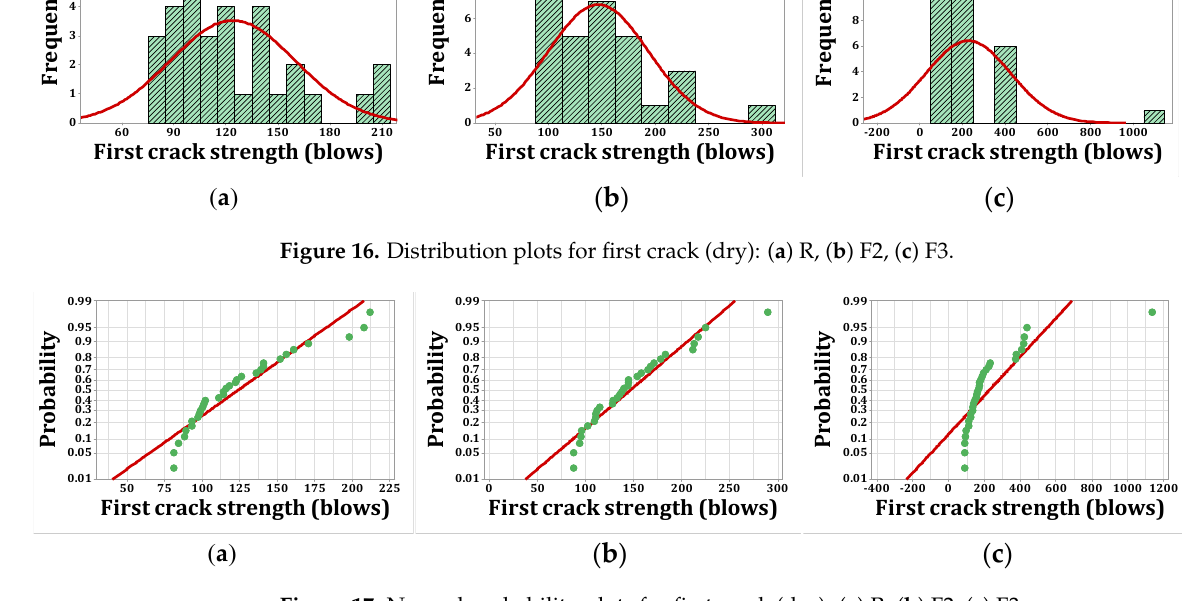
) b ( ) a ( Figure 18. Distribution plots for first crack (dry): ( a ) F5, ( b ) F2F3. ) b ( ) a ( Figure 19. Normal probability plots for first crack (dry): ( a ) F5, ( b ) F2F3. Figure 12a shows the frequency histograms, along with the normal plot, for reference concrete processed in a wet environment, which means that the resistance of the first crack of the reference concrete rarely follows a normal distribution. In addition, Figure 13a shows the normal probability plot of this mix. There is a low curvature plot in the lower half of the straight line that indicates a rarely normal distribution. On the other hand, the normal distribution of results was examined by the Kolmogorov–Smirnov test with a sig- nificance level of 0.05 (reported in Table 8). The p -value obtained for the first cracks of the reference concrete in a wet environment was 0.093, which confirms the above claim. Mix- tures of F2 and F23 follow the normal distribution in Figures 13b and 15b, respectively, due to the relatively close fit of the normal plot to the histogram (Figures 12b and 14b, respectively) and the almost linear pattern of the data. Additionally, the p -value obtained by the K–S test showed a value greater than 0.15, which confirms their normal distribu- tion. Mixtures of F3 and F5, however, do not follow the normal distribution due to the normal plot’s poor fit, shown in Figures 12c and 14a, respectively, aside from the intensive deviation of the results from the straightforward line (Figures 13c and 15a). The p -value of the K–S test was less than 0.01. Figures 16a and 17a show the normal distribution of reference concrete in a dry environment due to the acceptable fit of the normal plots to the histogram and linear pattern of the data. On the other hand, this mixture’s p -value was equal to 0.141. Mixtures of F3 and F2F3 do not follow the normal distribution due to the poor representation in Figures 16c and 18b as well as the nonlinear pattern in Figures 17c and 19b. In addition, the p -value confirms this result from the K–S test. Finally, the incor- poration of F5, according to Figures 18a and 19a, as well as a p -value equal to 0.093, shows